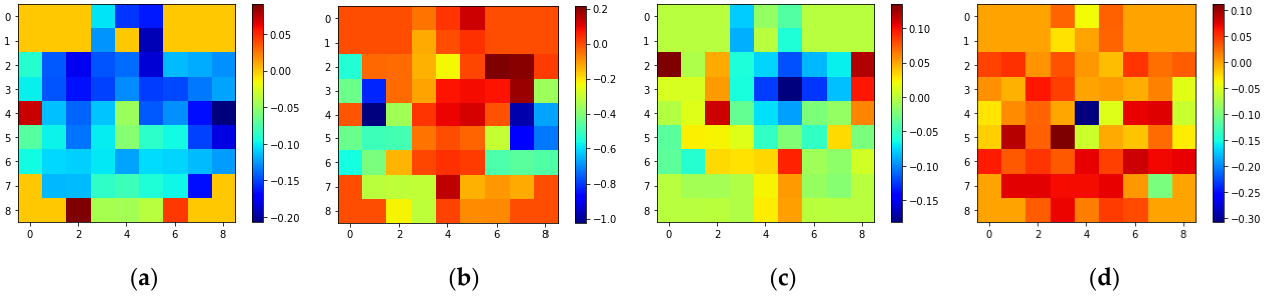
Figure 3. 2D 9 × 9 EEG frame samples of different emotions of SEED-IV: ( a ) Happiness; ( b ) Sadness; ( c ) Fear; ( d ) Neutral.